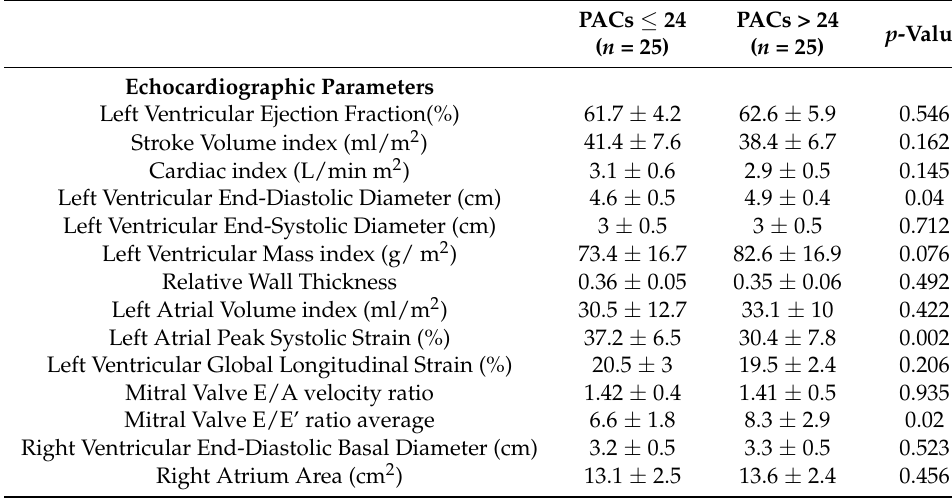
Table 2. Cardiac imaging parameters in β -thalassemia-major patients with premature atrial contrac- tions ≤ 24/day and >